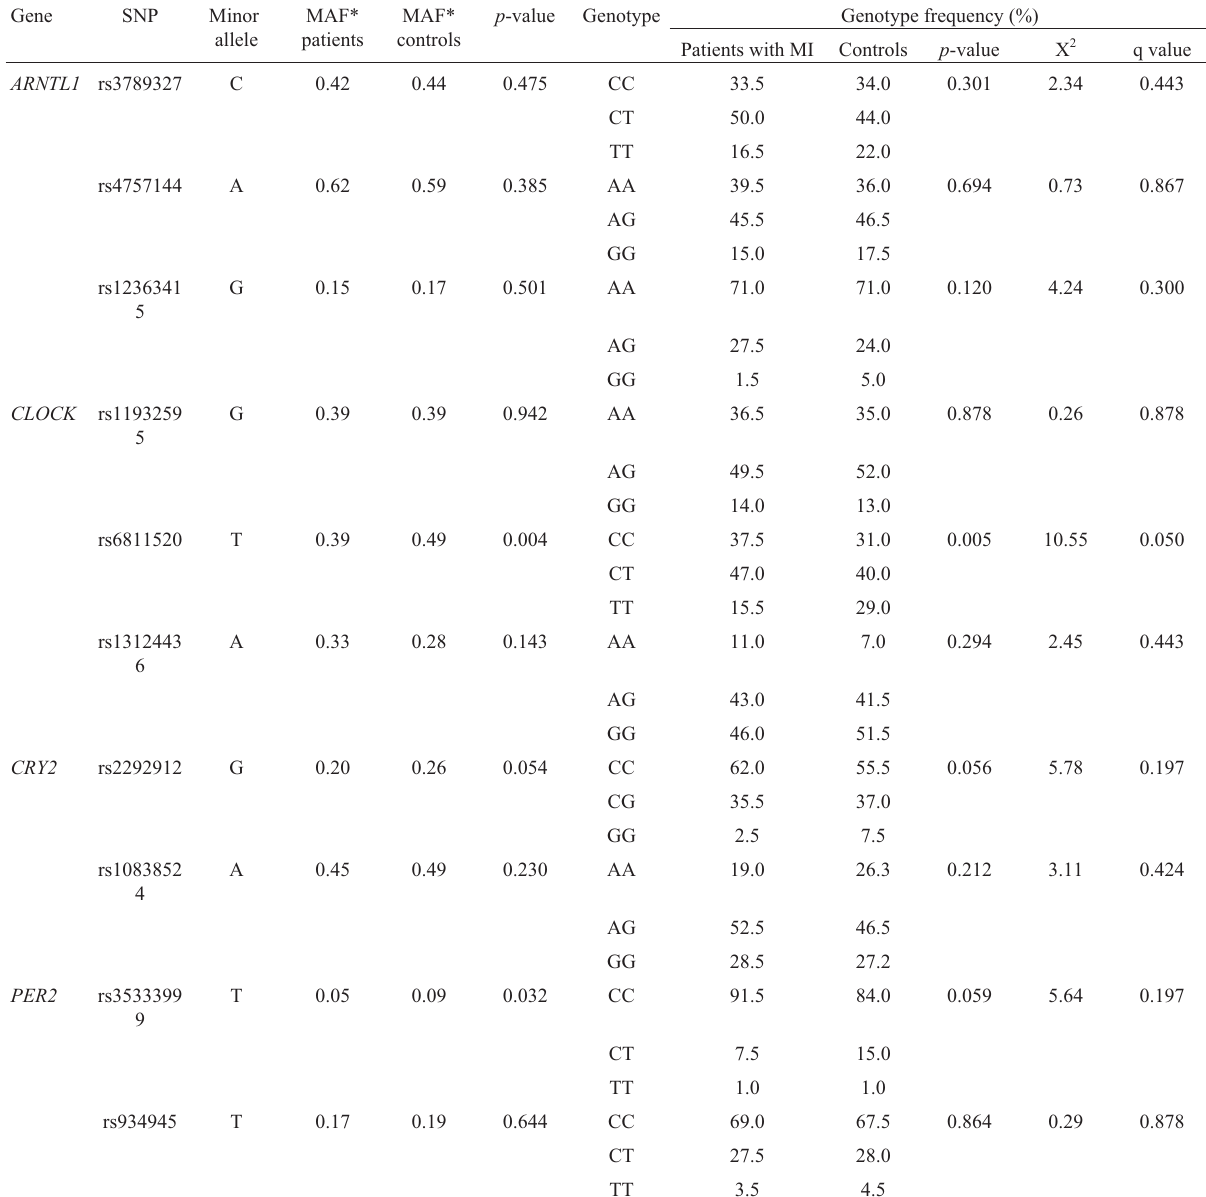
Table 2 - Allele and genotype distribution and frequencies of the ARNTL , CLOCK , CRY2 and PER2 polymorphisms. Gene SNP Minor allele